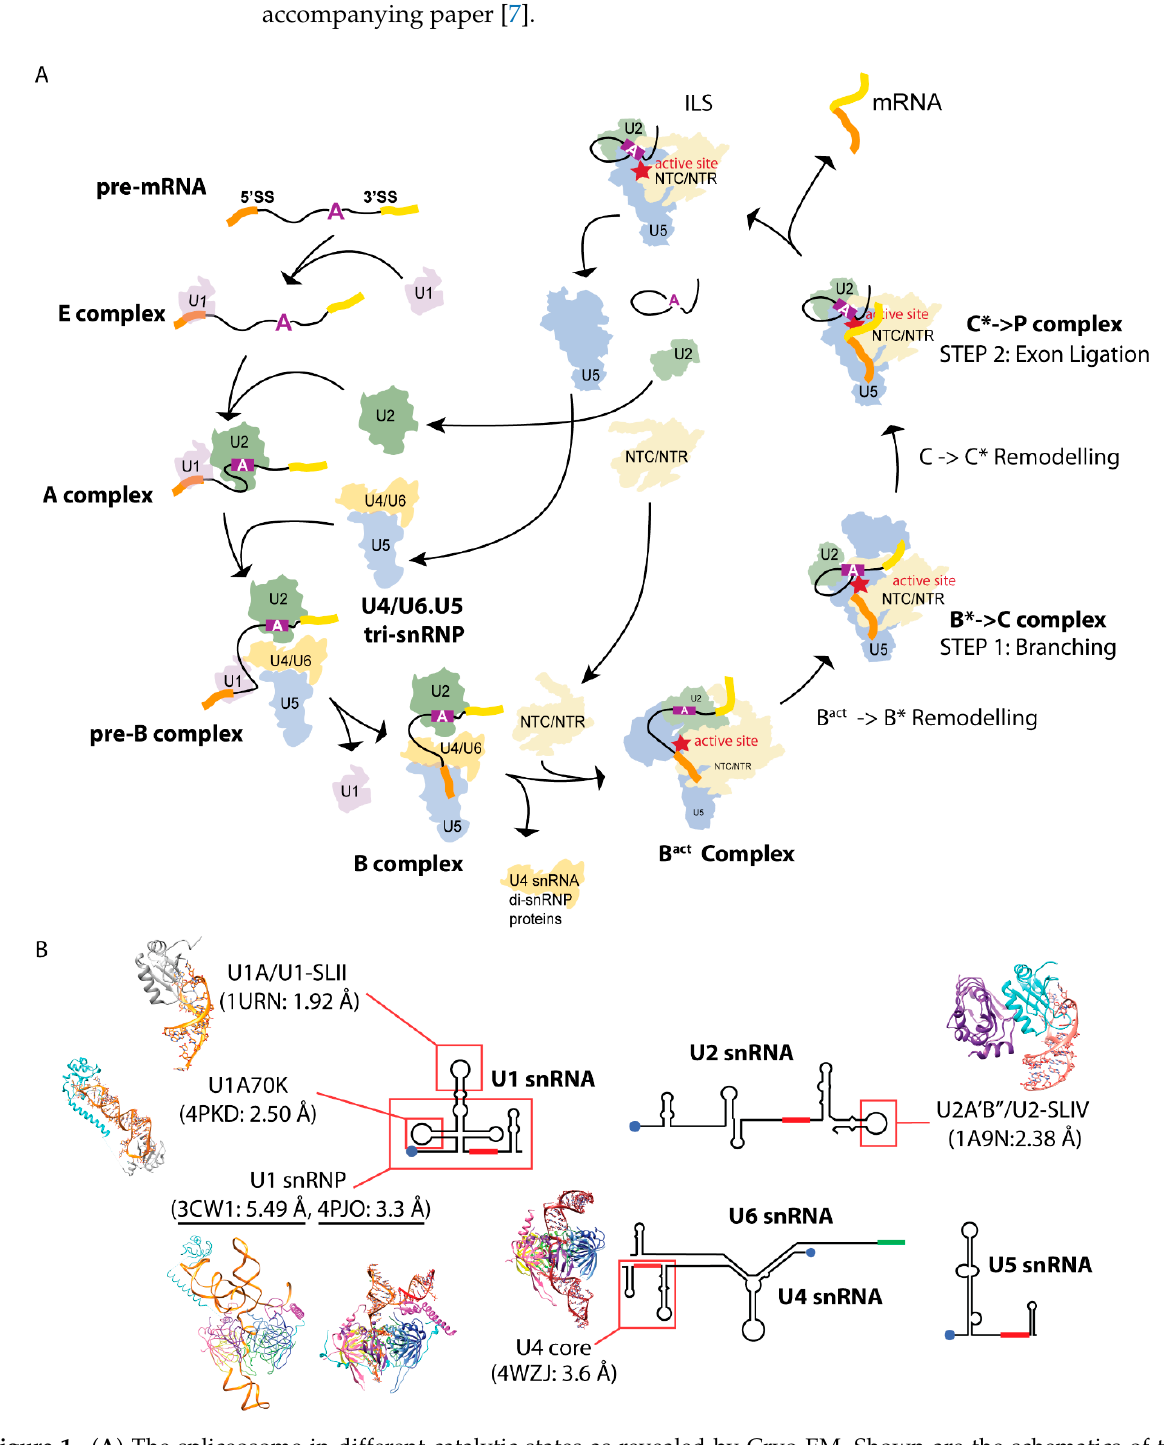
Figure 1. ( A ) The spliceosome in different catalytic states as revealed by Cryo-EM. Shown are the schematics of the pre-mRNA and the silhouettes of each splicing complex from Cryo-EM structures. Proteins involved in remodeling the spliceosome are not included. NTC/NTR are protein complexes that help sculpt the active site of the spliceosome together with U2, U5, and U6 snRNPs. Prespliceosome (E, A complex): U1 snRNP recognizes the 5 ′ splice site (5 ′ ss) forming the E complex. U2 snRNP recognizes and the invariant adenosine on the branch point (purple box) forming the A complex. Precatalytic spliceosome (Pre-B, B Complex): The U4/U6.U5 tri-snRNP enters to form the Pre-B complex and the helicase-dependent dissociation of U1 snRNP generates the B complex. Activated spliceosome (B act- Complex, B*, C, C*):